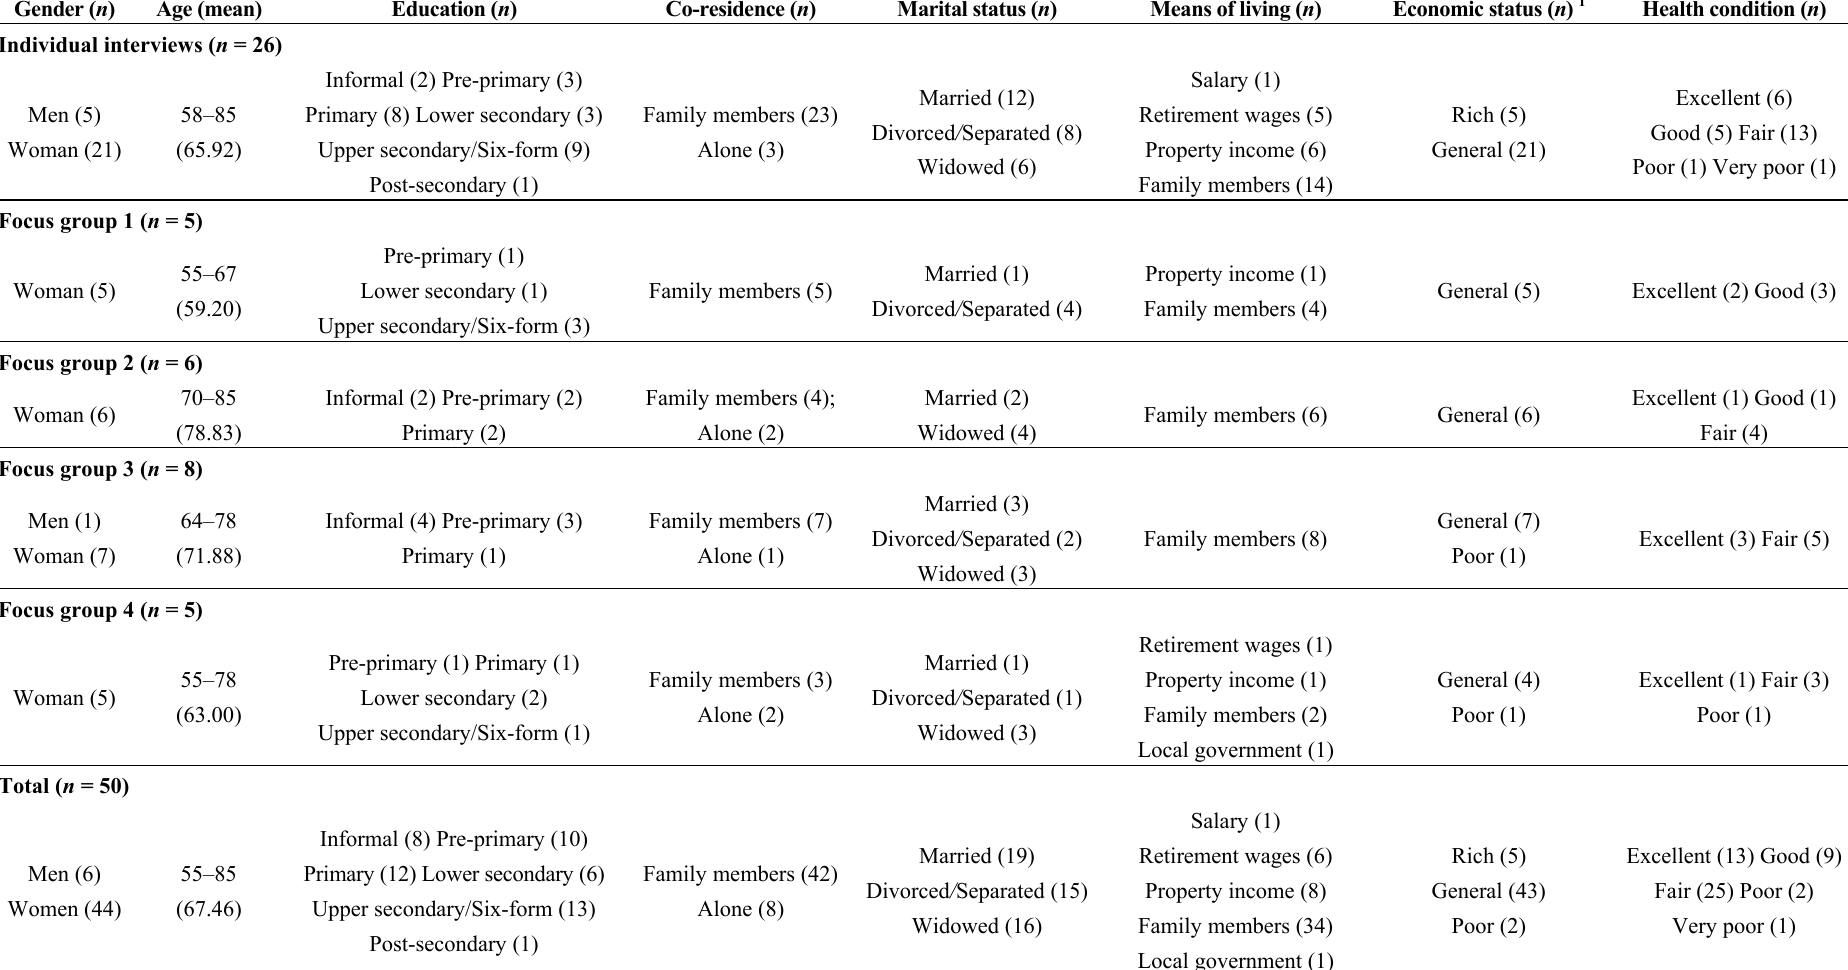
Table 1. Demographics of the participants ( n =